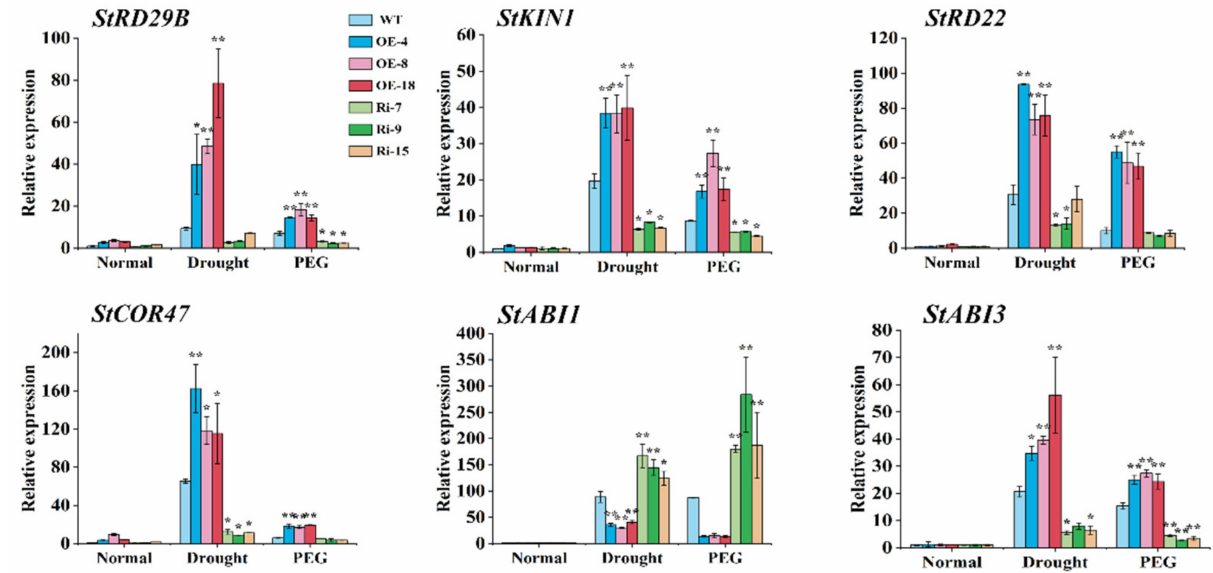
Figure 7. Expression levels of drought- and ABA-responsive genes are altered in WT and transgenic potatoes under drought and PEG stress. Data are mean ± SD ( n = 3 ). Significance compared with normal conditions was determined using the ANOVA Duncan’s test; p < 0.05, significant (*); p < 0.01, highly significant